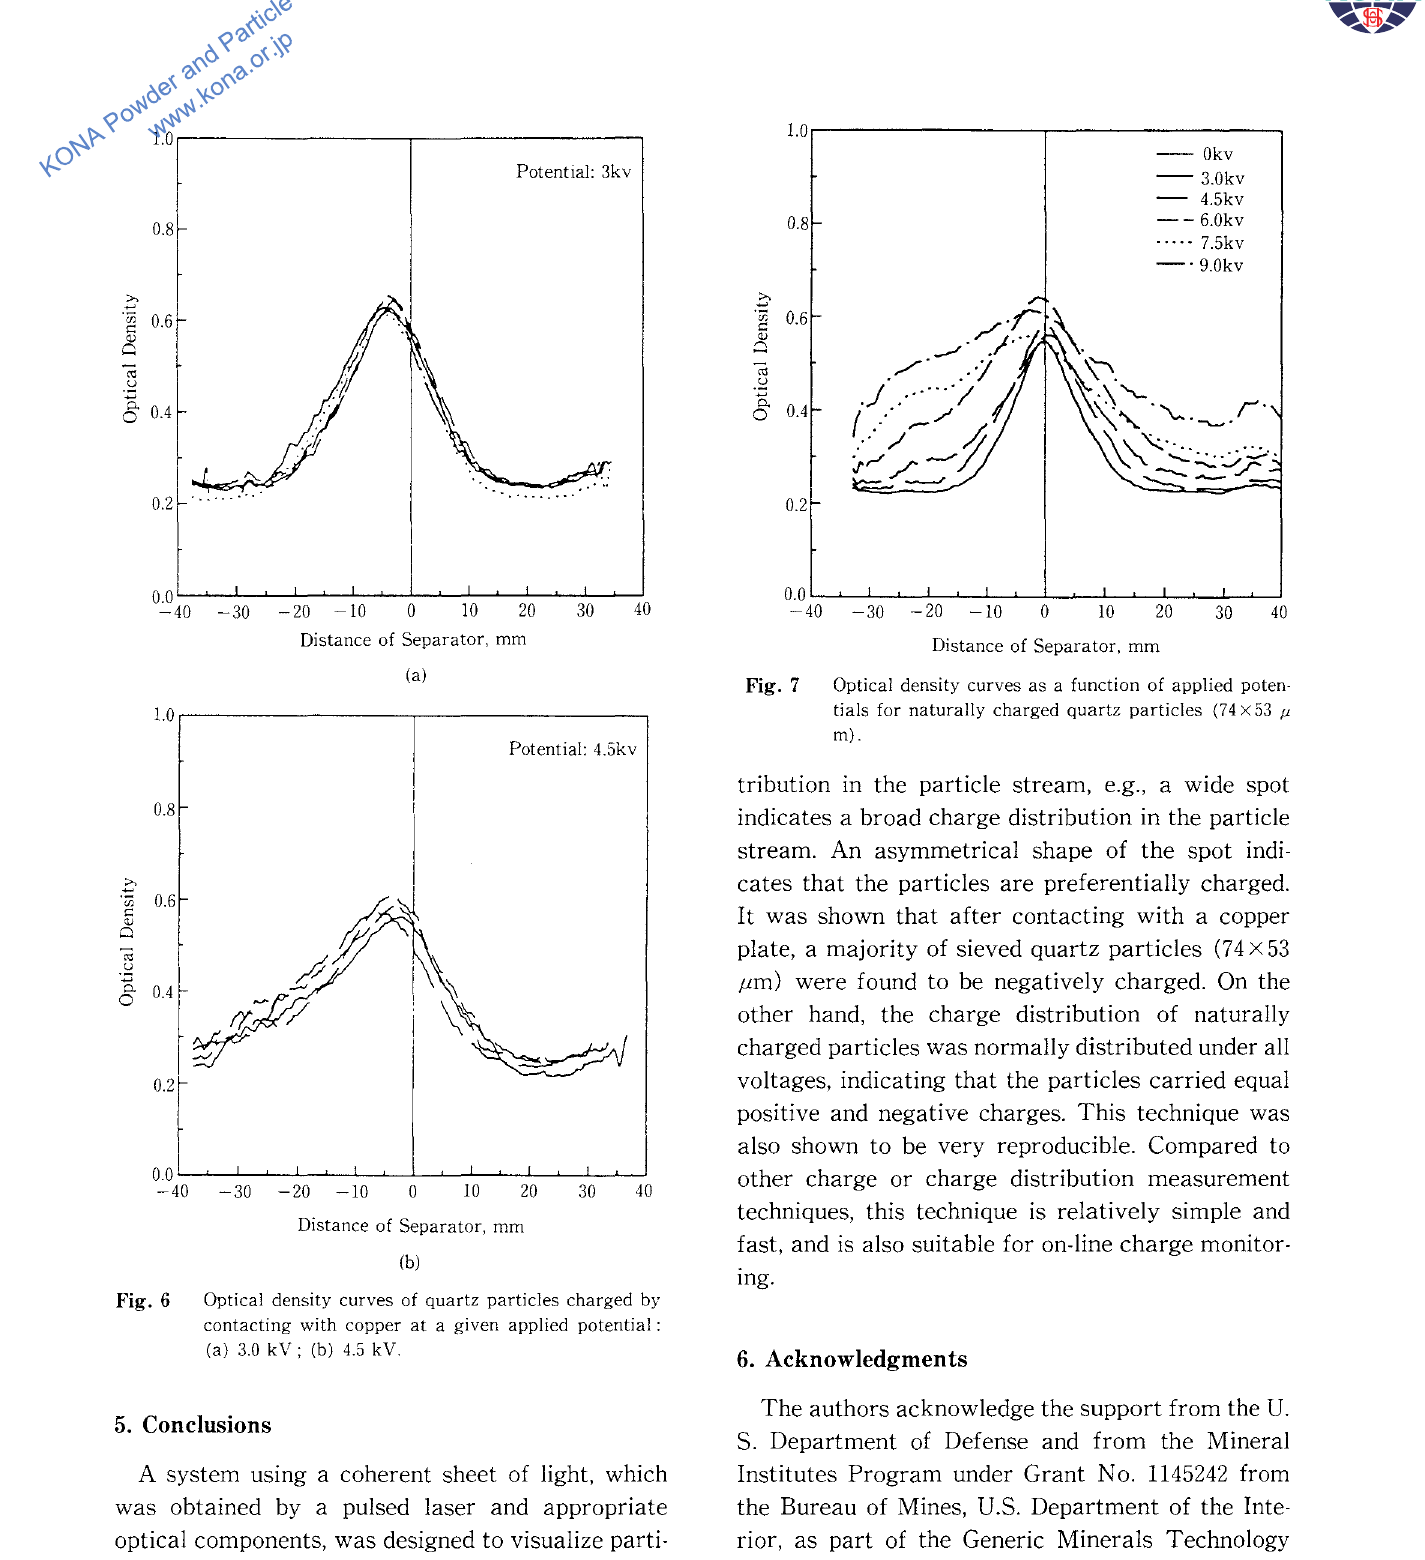
Fig. 7 Optical density curves as a function of applied poten tials for naturally charged quartz particles (74 x 53 11 m). tribution in the particle stream, e.g., a wide spot indicates a broad charge distribution in the particle stream. An asymmetrical shape of the spot indi cates that the particles are preferentially